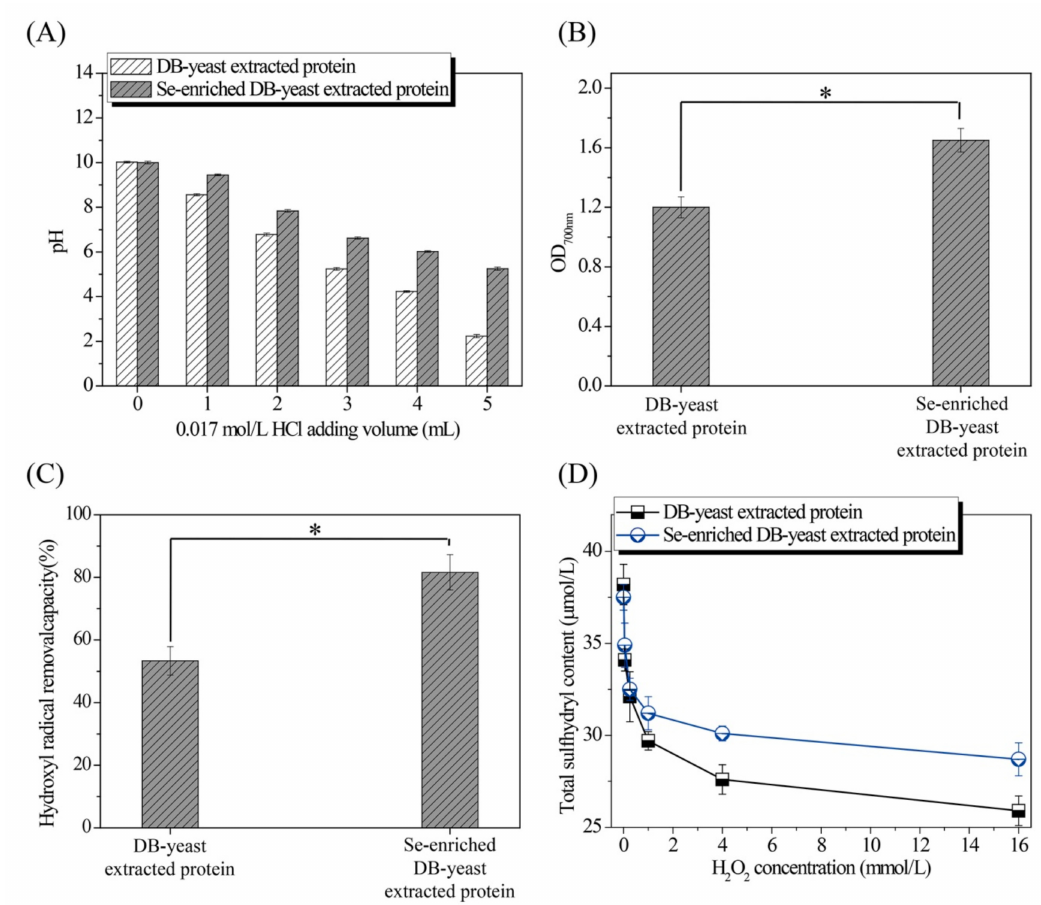
Figure 5. Characterization of DB-yeast and Se-enriched DB-yeast extracted proteins. ( A ) pH of extracted proteins (20 mL) after mixing with 0.017 mol / L HCl (0 to 5 mL). ( B ) Reducing power of extracted proteins (10.0 mg / mL of extracted proteins). ( C ) Hydroxyl radical removal capacity of extracted proteins (0.4 mg / mL of extracted proteins). ( D ) E ff ect of di ff erent H 2 O 2 concentrations on total sulfhydryl content (3.6 mg / L of extracted proteins). * Statistically significant ( p -value <